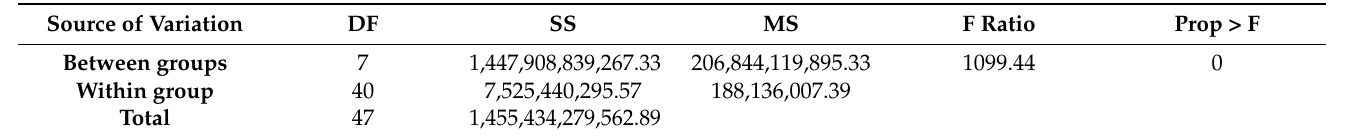
Figure 2. Linear fit of the calibration curves (n = 6). Each colour represents the eight points of a calibration curve (6 colours for 6 calibration curves). The solid black line represents the linear fit for the whole data. Table 2. Results of the analysis of variance (ANOVA) test for the calibration curves data. Source of Variation Prop >